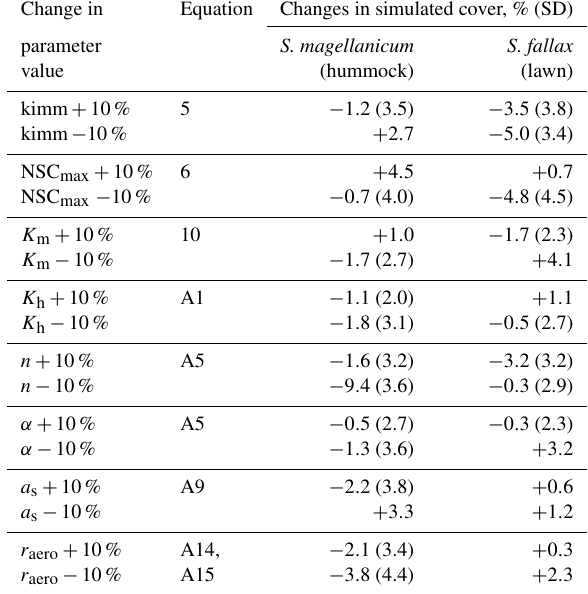
Table 3. The results from Test 2, which addressed the robustness of the model to the uncertainties in a set of parameters. Each parameter was increased or decreased by 10%. The model was run for S. mag- ellanicum and S. fallax in their preferential habitats. The difference in mean cover between simulations as a function of changed or un- changed parameter values is given; the standard deviations (SD) of the means are given in parentheses. The parameters include the spe- cific immobilization rate (kimm), the maximal nonstructural carbon (NSC) concentration (NSC max ), the hydraulic conductivity of the moss layer ( K m ), the hydraulic conductivity of the peat layer ( K h ), the water retention parameters of the water retention curves ( α and n ), the snow layer surface albedo ( a s ), and the aerodynamic resis- tance ( r aero